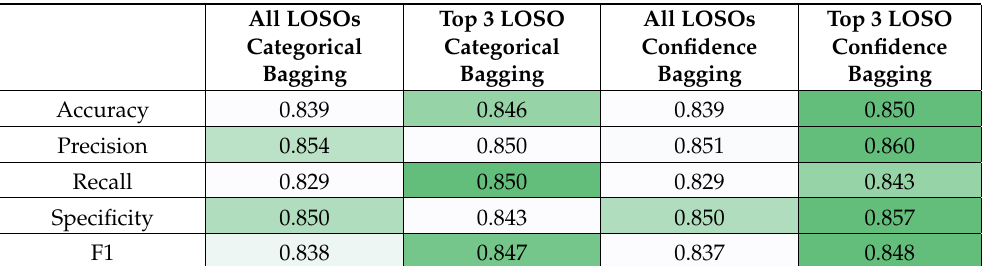
Table 3. Performance metrics for each ensemble method with augmentation + no MixUp ShrapML model architecture. Mean results for two separate blind test subjects are presented. Heat map overlay is set between the minimum and maximum value for each performance